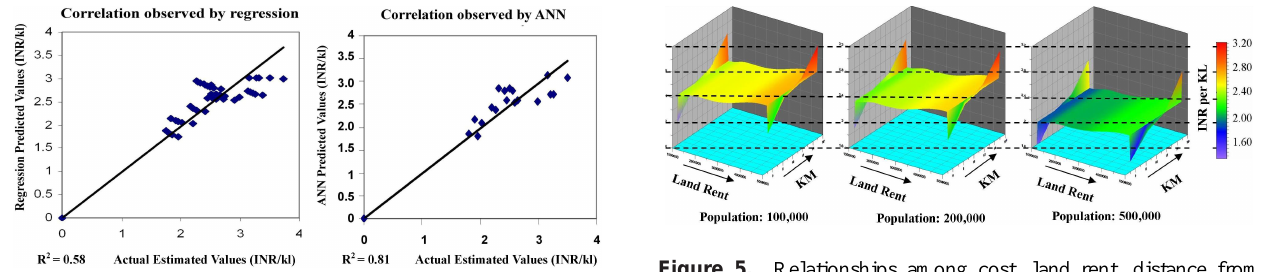
Figure 4. Correlation coe ffi cient ( R 2 ) for estimated prediction and actual values.